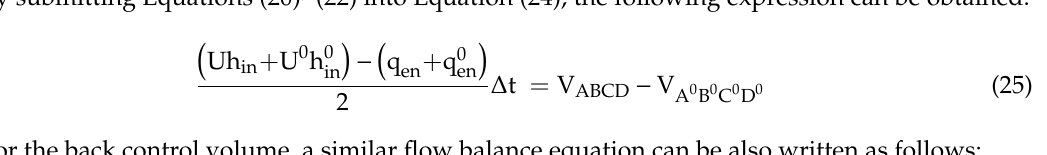
Figure 4. Schematic diagram of the oil transport model.